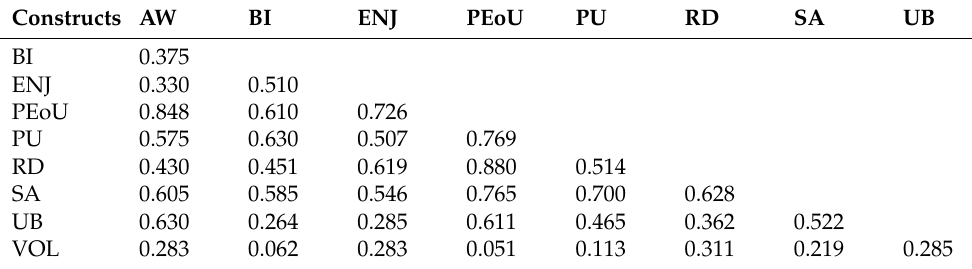
Table 4. Discriminant validity (HTMT).